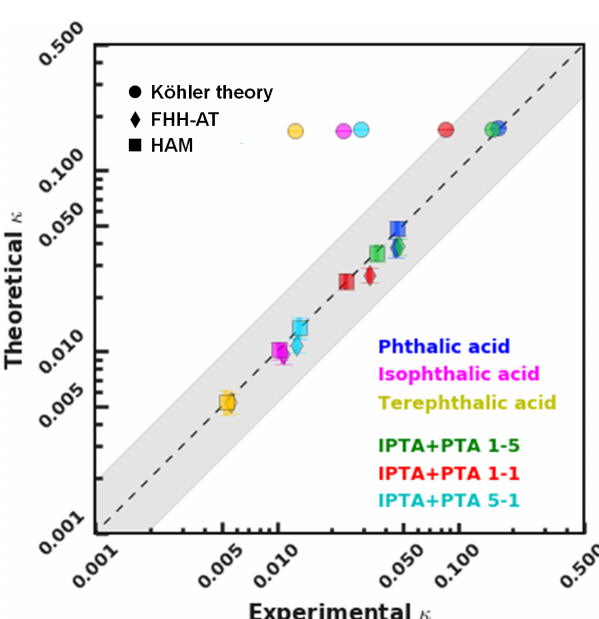
Figure 4. S vs. D dry , c data obtained from supersaturated CCN mea- surements of pure and internally mixed AAA samples. HAM fits applied to the experimental data are shown as dot-dashed lines.